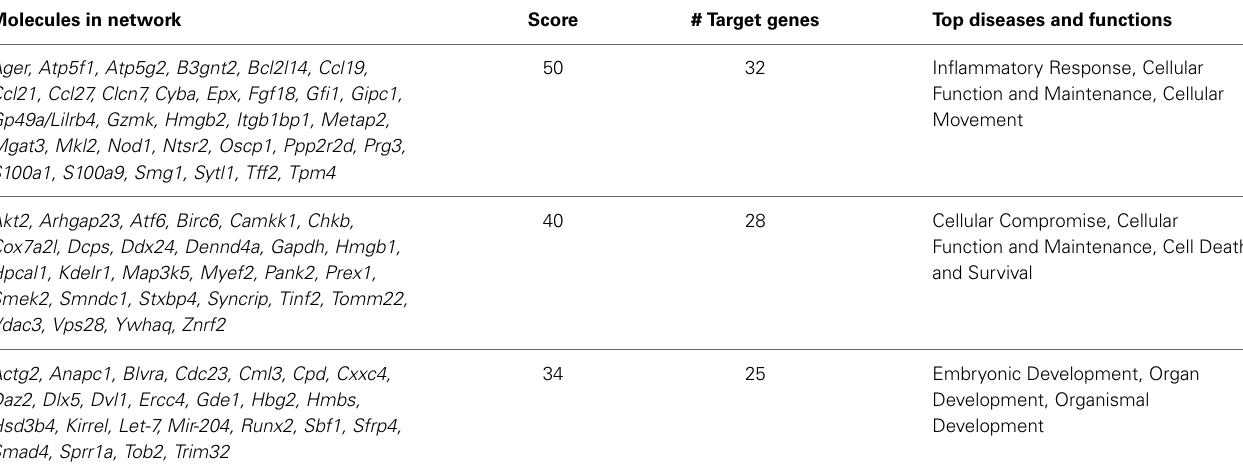
Table 1 | Networks of NTO/NTC overlapping genes between C57BL/6NHsd and DBA/2NHsd. Molecules in network Score # Target genes Top diseases and functions Ager, Atp5f1, Atp5g2, B3gnt2, Bcl2l14,